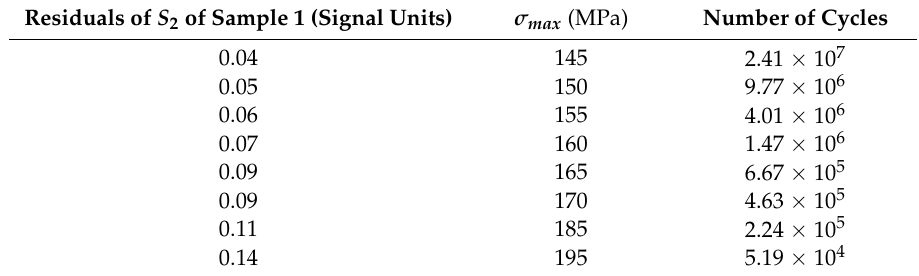
Table 5. Evaluation of number of cycles of thermographic S-N curve by using the model of Equation (5). Residuals of S 2 of Sample 1 (Signal